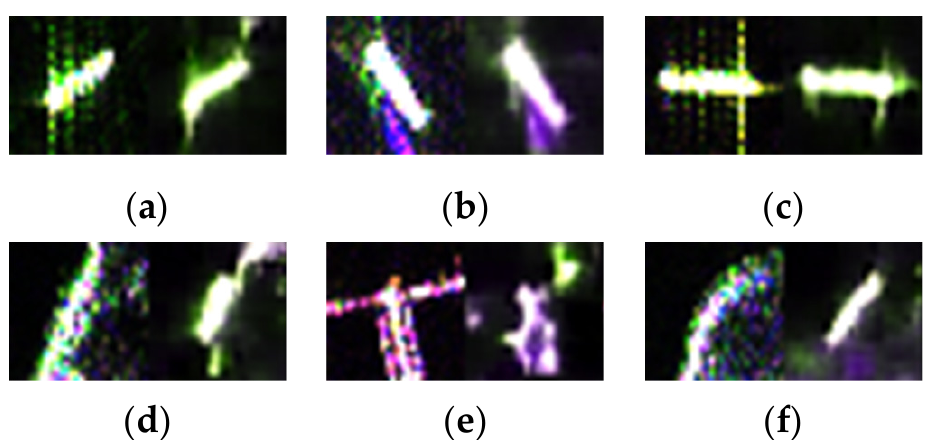
Table 5. Detection precision and recall rate of both two-parameter CFAR and our method. Com- pared with the former approach, ours removed more false alarms.